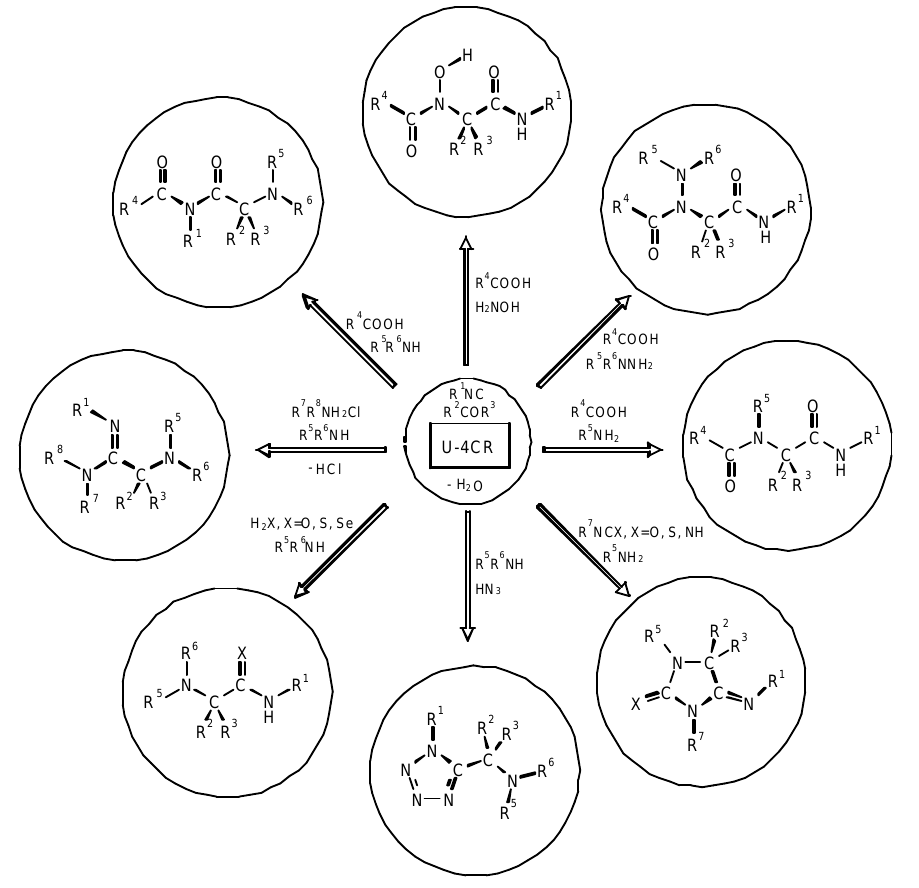
Scheme 4: The variability of U-4CR